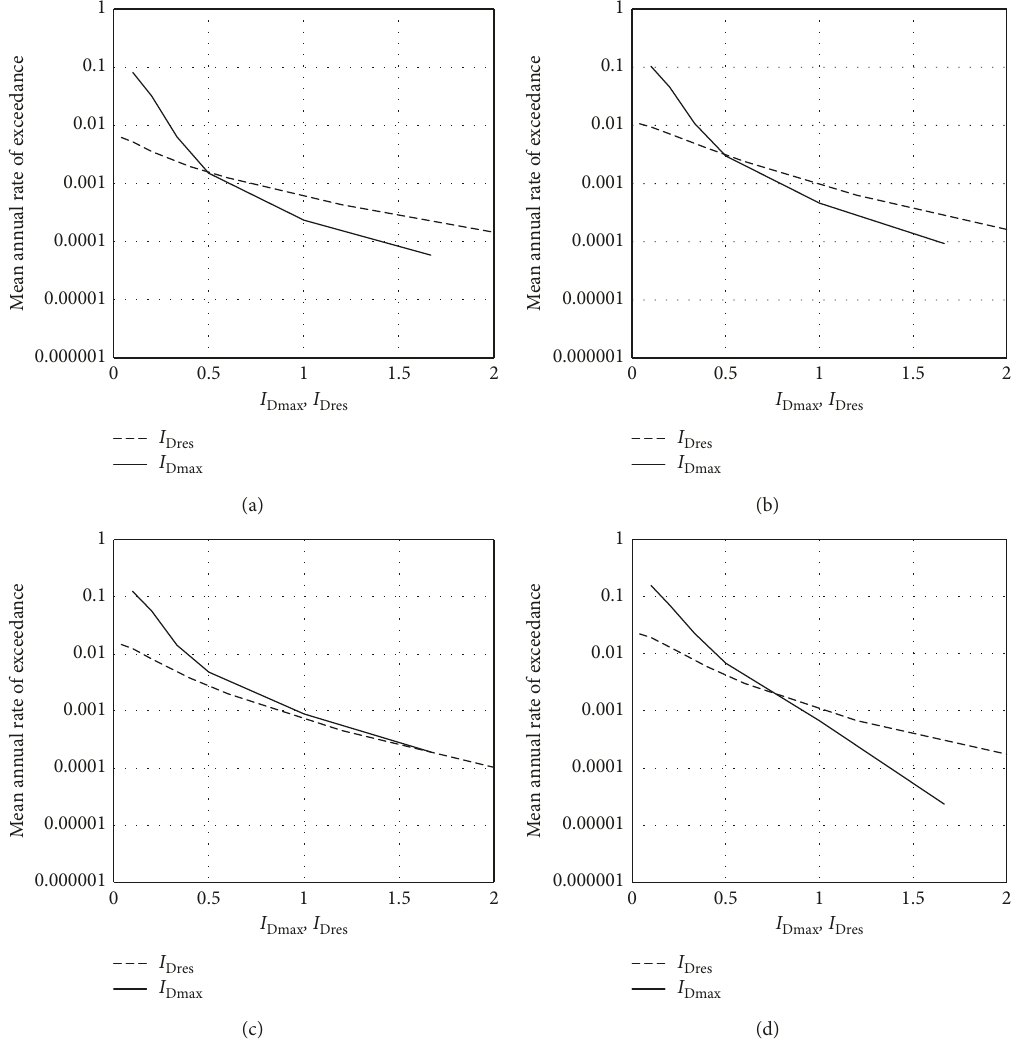
Figure 5: Comparison of the I Dmax and I Dres hazard curves for the MRSFs: (a) F4, (b) F6, (c) F8, and (d)